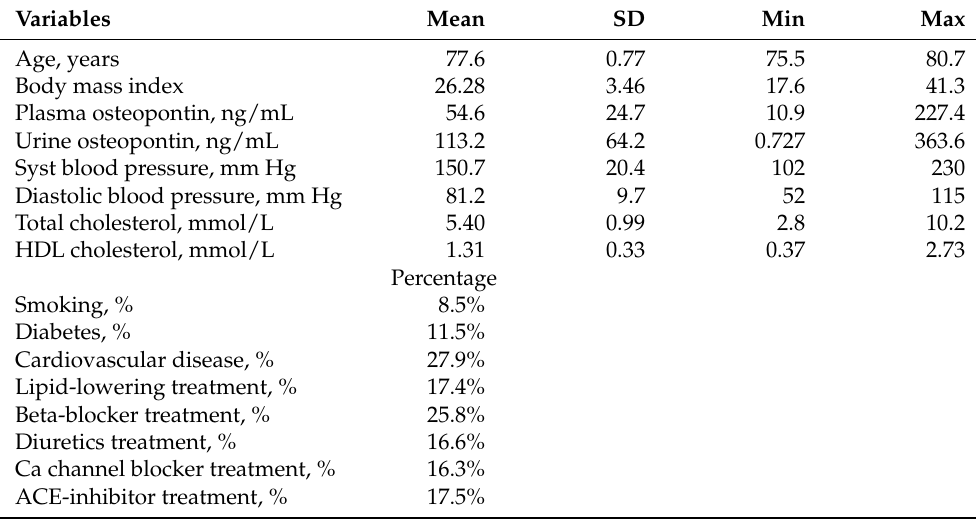
Table 1. Basic characteristics of the population ( n =